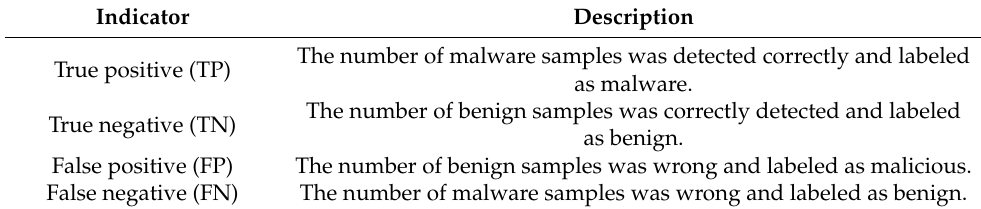
Table 4. Description of the Confusion Matrix.